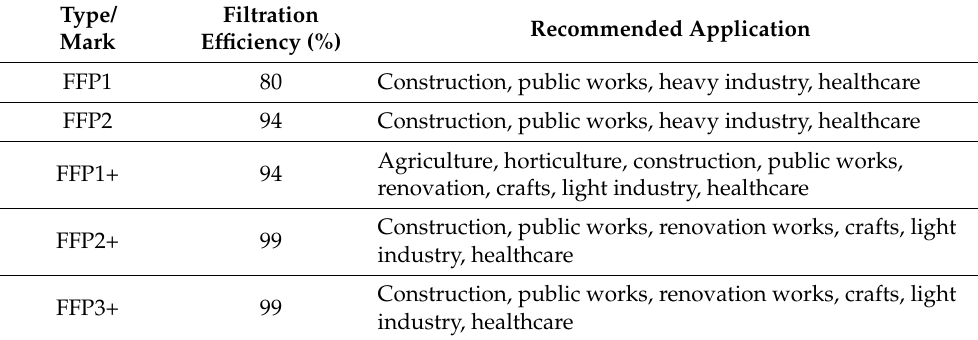
Figure 1. Filtering half masks—the research material. In columns: FFP1, FFP2, FFP1+, FFP2+, FFP3+. Table 1. Filtering half masks—research material, Reprinted/adapted with permission from Ref.